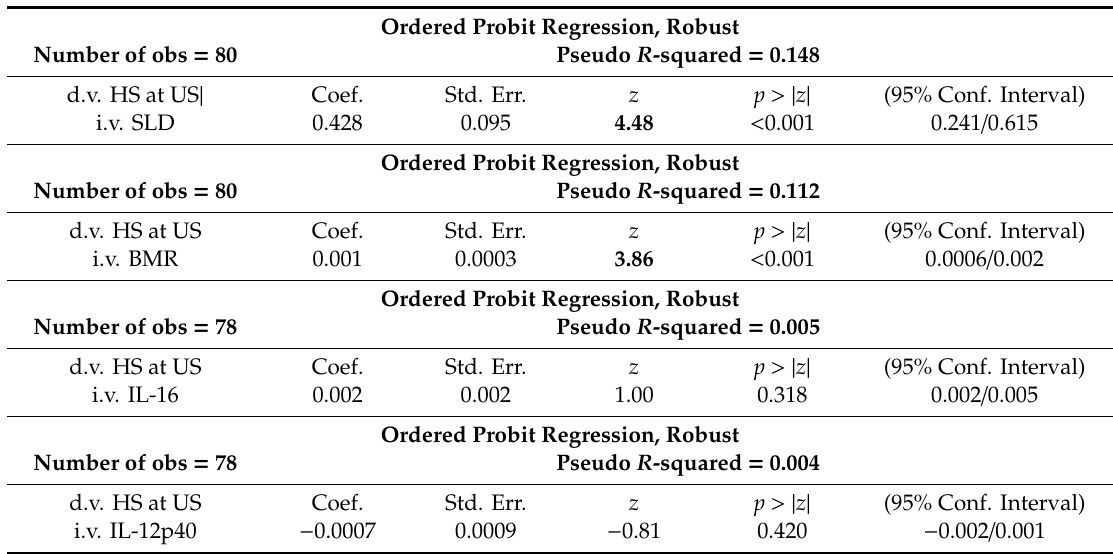
Legend to Table 7: BMR, basal metabolic rate; SLD, spleen longitudinal diameter at ultrasonography; HGF, hepatic growth factor. The correlation estimates tells us about the endogeneity in our model of extended linear regression, i.e., HGF is an endogenous variable, playing likely a causal role. Although the Prob > chi2 was significant due to the large coe ffi cient, the F-statistic (Wald chi square) against the null, i.e., that the excluded endogenous variable are irrelevant in the first-stage regression, should have been larger than 10 to demonstrate that instruments / covariate / endogenous / explanatory variables are weak according to Staiger and Stock’s Rule of thumb;